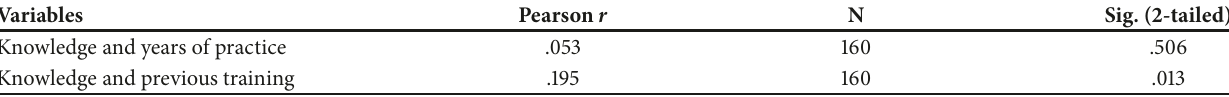
Table 5: Correlations between knowledge and selected background features.